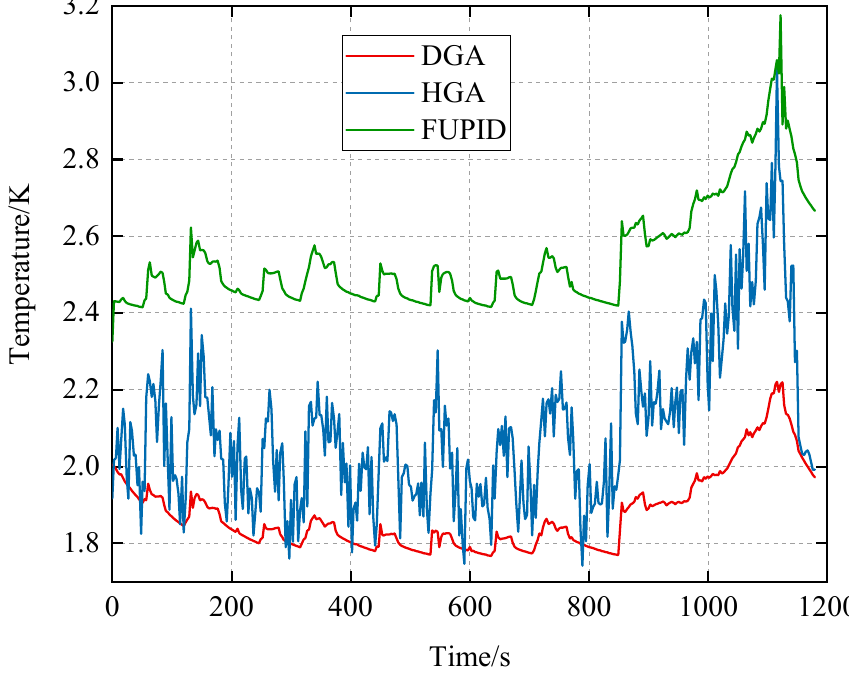
Figure 17. Three strategies of reactor inlet and outlet temperature variation diagram. Table 7. Statistical table of water temperature